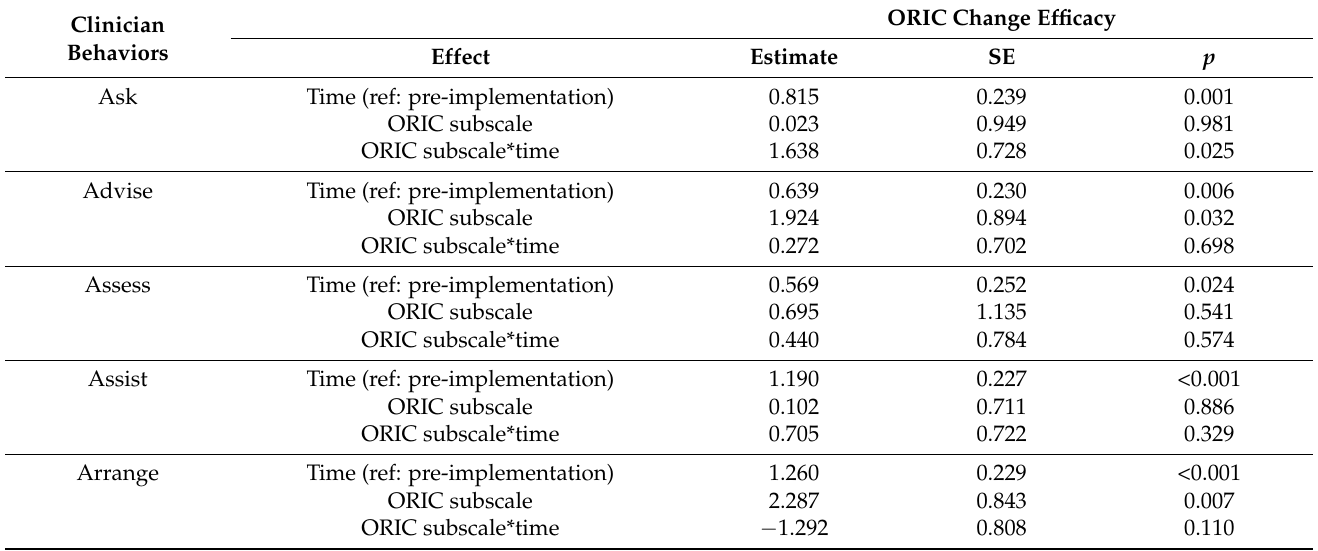
Table 1. Adjusted model of organizational readiness for change subscales as moderators of clinician screening and treatment behaviors pre- to post-program